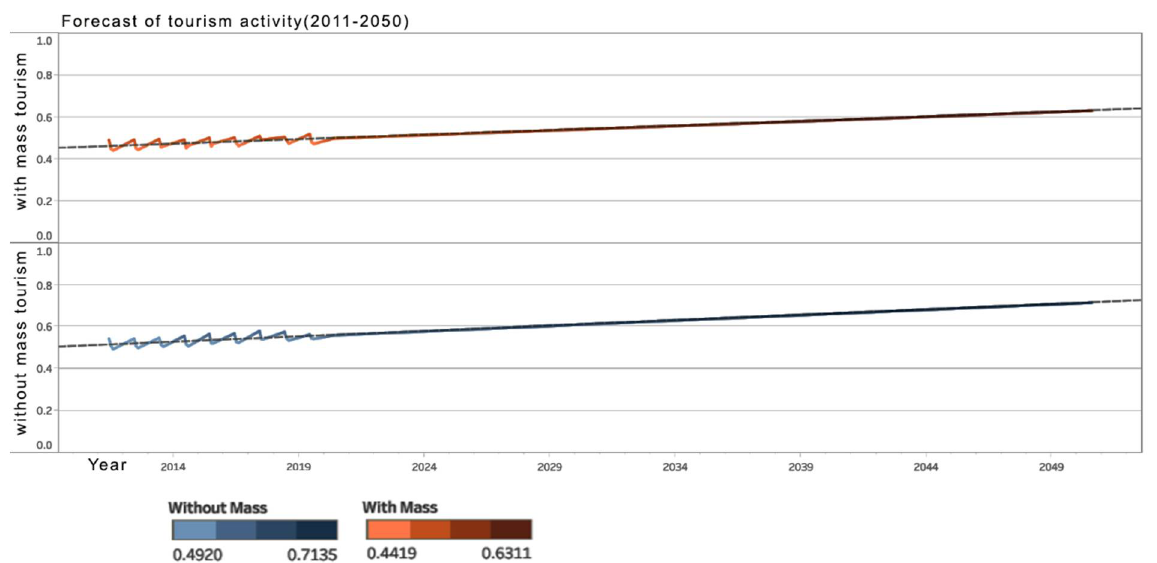
Figure 18. Forecast of indicator averages for the two scenarios for 2011–2050